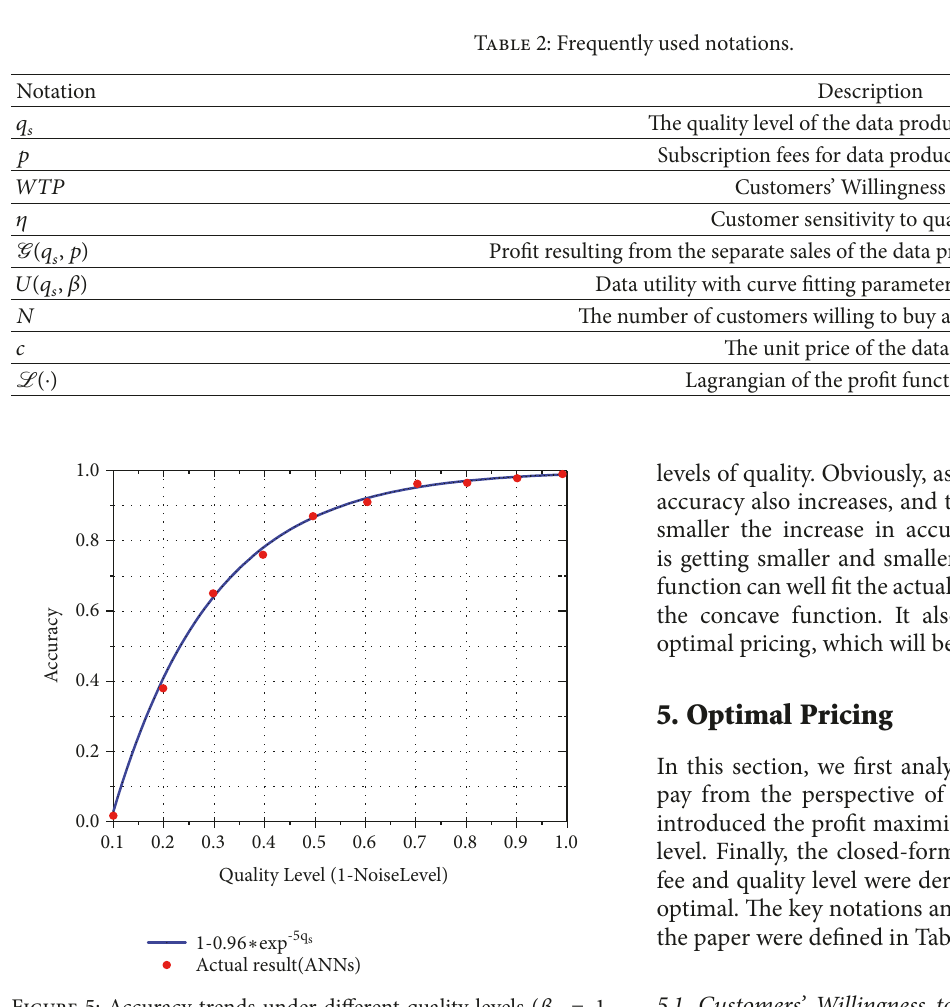
Figure 5: Accuracy trends under different quality levels ( 𝛽 1 = 1 , 𝛽 = 0.96 , 𝛽 = −5 2 3